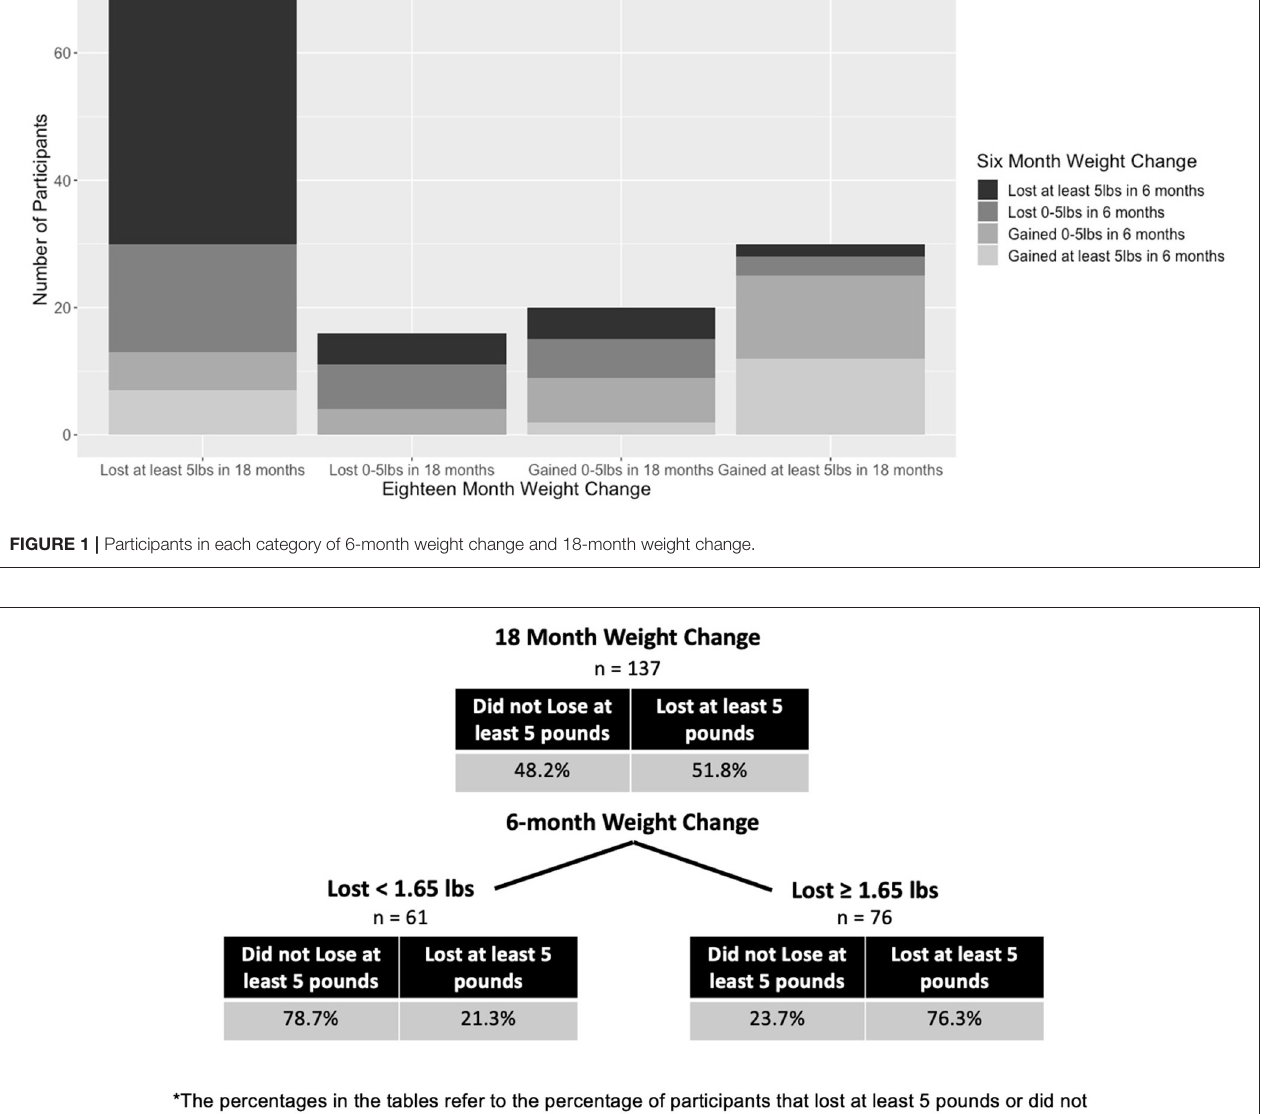
FIGURE 2 | Classification tree for 18-month weight